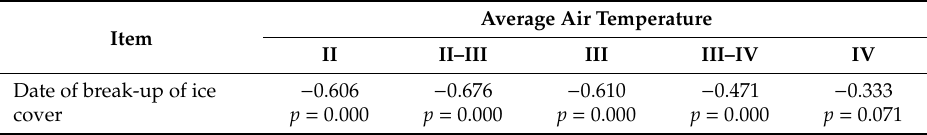
Table 4. Pearson’s correlation coe ffi cients between meteorological data and dates of ice cover break up for the Kozłowa G ó ra water